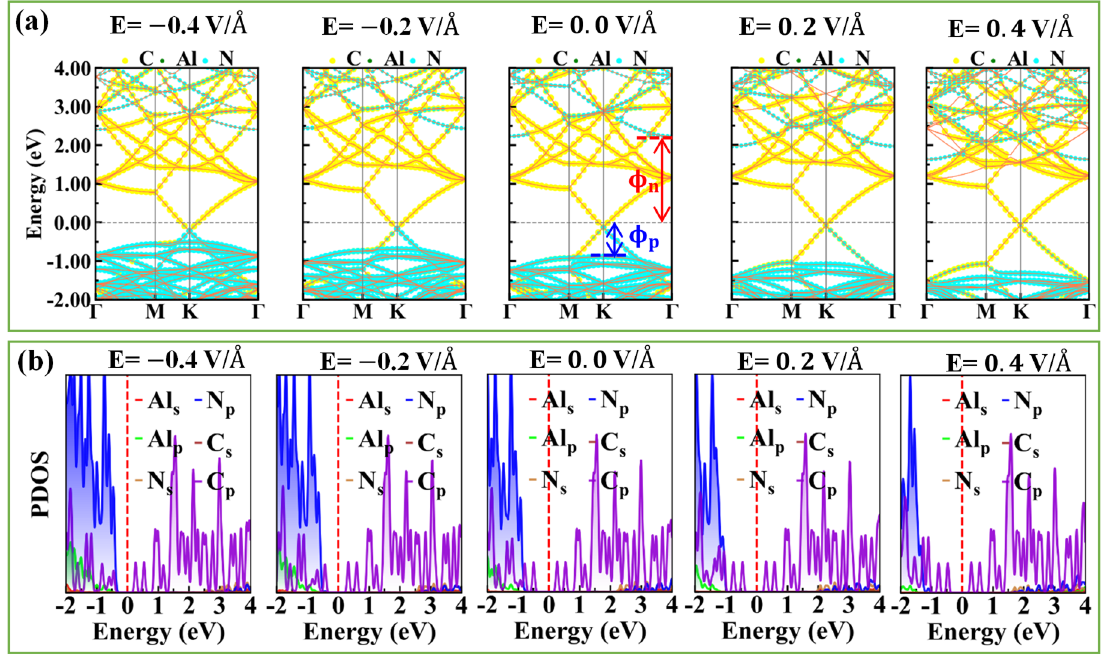
Figure 3. ( a ) The projected band structure of the graphene / AlN heterojunction under external electric field ranging from − 0.4 V / Å to 0.4 V / Å. ( b ) The projected density of states of graphene / AlN heterostructure under the corresponding external electric field. Fermi level was aligned to 0 eV. The Schottky barrier height (SBH) is defined in Figure 3a, where Φ n is the n-type SBH, and Φ p is the p-type SBH.